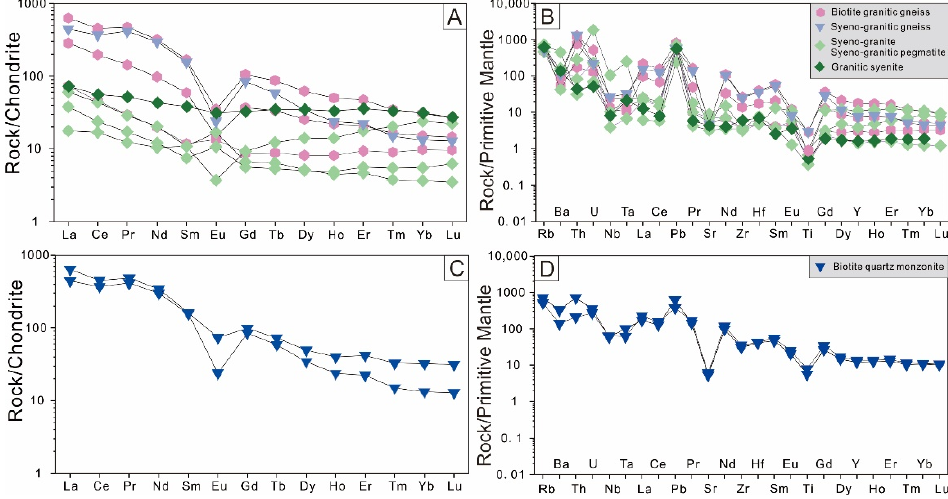
Figure 5. ( A , C ) chondrite-normalized REE patterns, ( B , D ) primitive mantle-normalized trace ele- ment abundance patterns ( B , D ). Both chondrite- and primitive-normalization values are taken from Sun and McDonough [47].